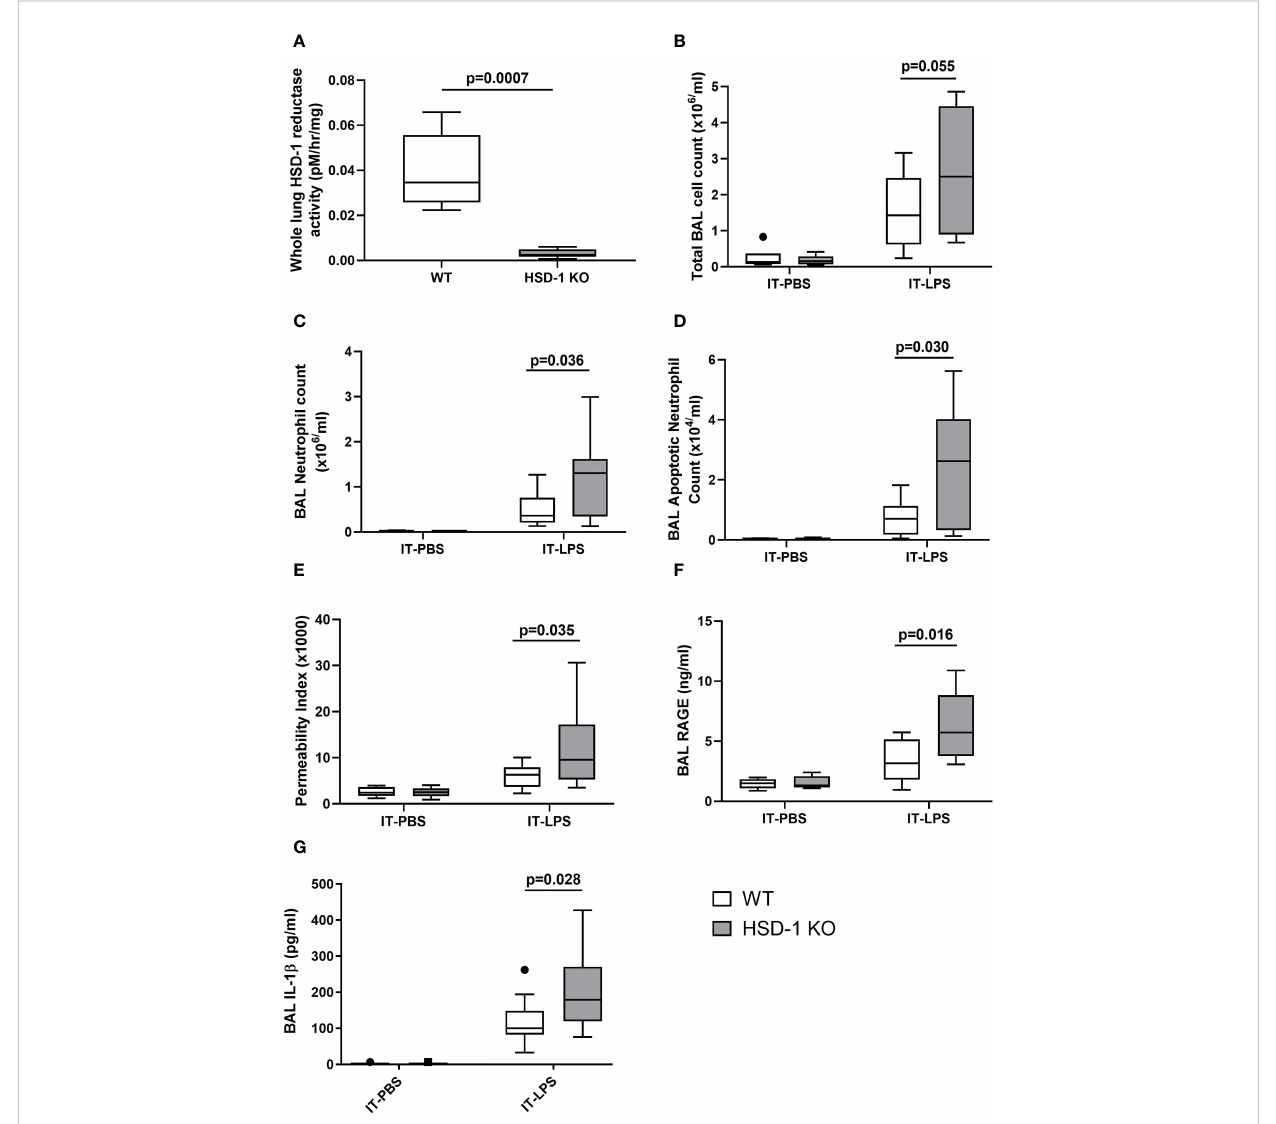
FIGURE 3 IT-LPS injury in HSD-1 knockout mice is associated with increased alveolar neutrophil in fi ltration, alveolar permeability and RAGE concentrations. Time course of IT-PBS and IT-LPS injury was 48 hours. For IT-LPS, n ≥ 10 each group. For IT-PBS, n=6 per group. Data shown as Tukey ’ s box plots. (A) Whole lung HSD-1 reductase activity in uninjured WT and HSD-1 KO mice (medians 0.0345 vs 0.0025 pM/hr/mg, p=0.0007, n ≥ 5 per group). (B) BAL total cell count in HSD-1 KO and WT (IT-LPS treated medians 2.50 v 1.43 x10 6 /ml, p=0.055). (C) BAL neutrophil counts in HSD-1 KO and WT mice (IT-LPS treated medians 1.30 v 0.362 x10 6 /ml, p=0.036). (D) BAL apoptotic neutrophil counts in HSD-1 KO and c WT mice (IT-LPS treated medians 2.62 v 0.701 x10 4 /ml, p=0.030). (E) Alveolar protein permeability in HSD-1 KO and WT mice (IT-LPS treated medians 9.55 v 6.30 x10 3 , p=0.035). (F) Concentrations of BAL RAGE in HSD-1 KO and WT mice (IT-LPS treated medians 5.74 v 3.17 ng/ml, p=0.016). (G) Concentrations of BAL IL-1 b in HSD-1 KO and WT mice (IT-LPS treated medians 179 v 100 pg/ml, p=0.028). BAL, Broncho-alveolar lavage; HSD-1, 11 b